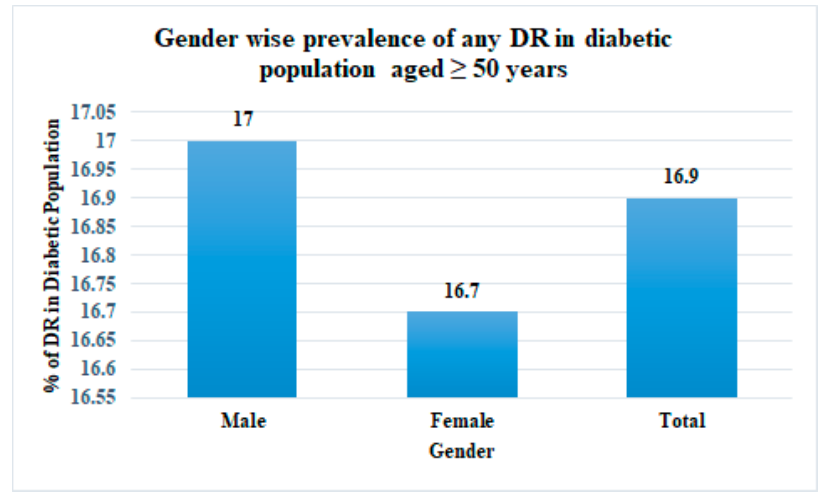
Figure 3. Gender-wise prevalence of any DR in the diabetic population aged ≥ 50 years.